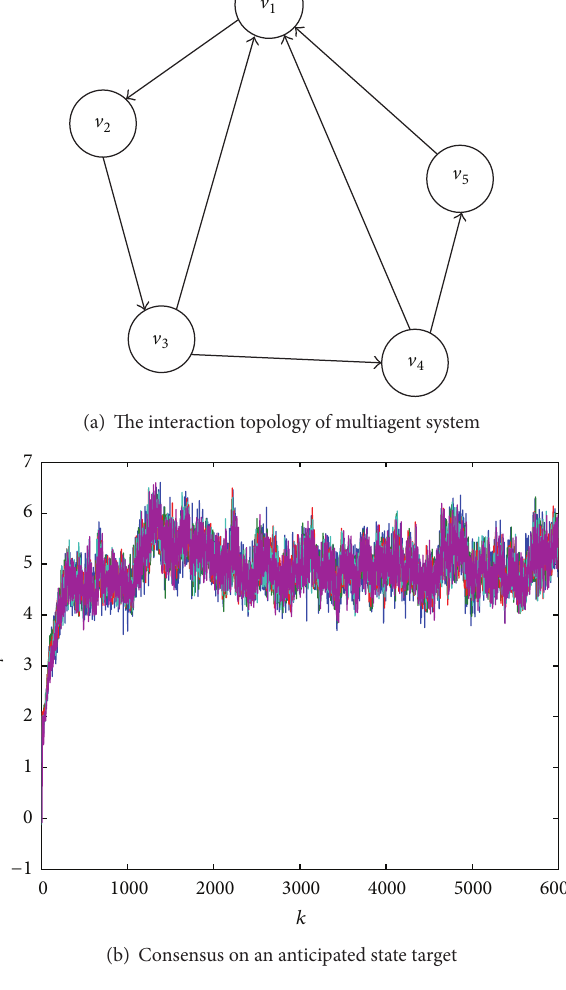
Figure 1: Numerical